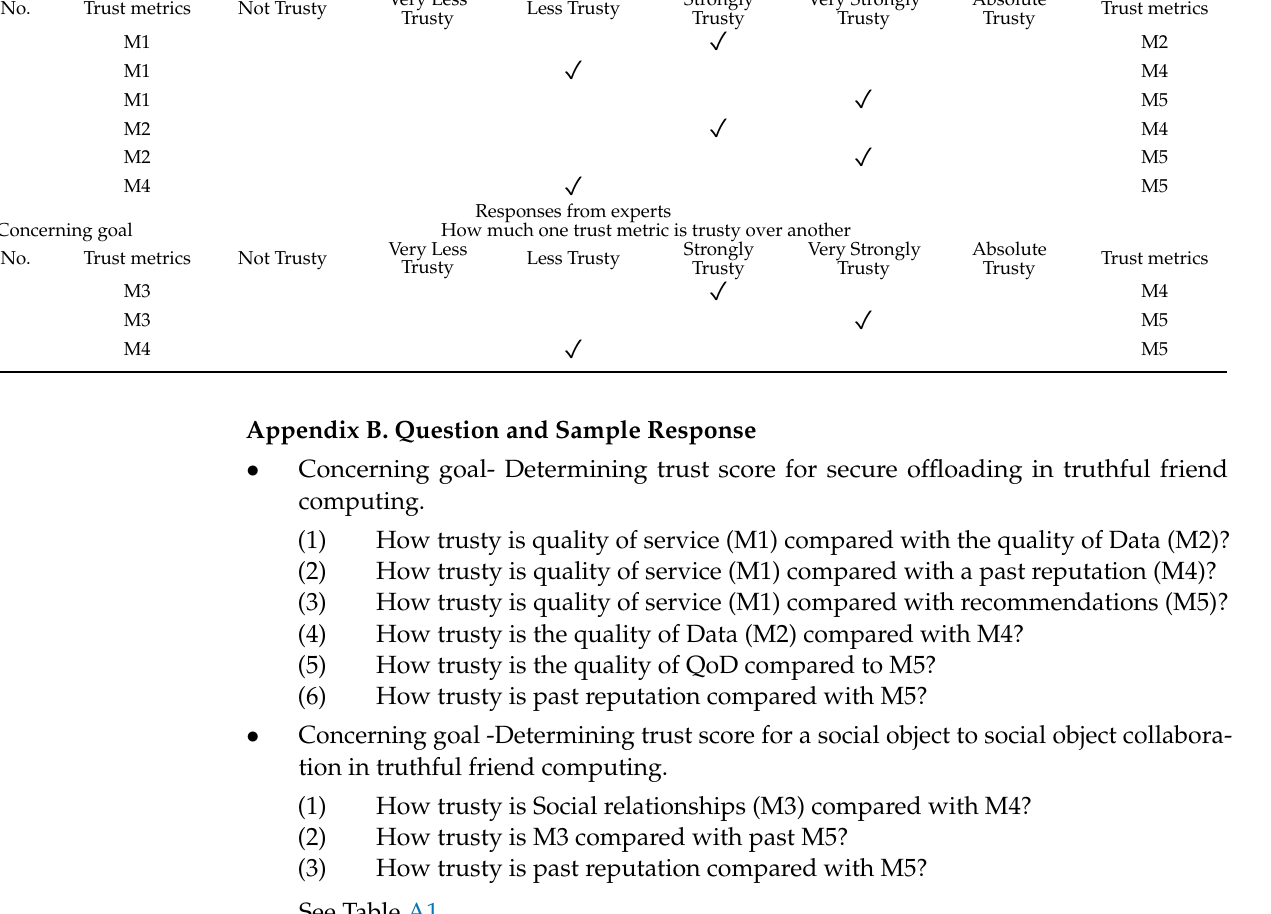
Table A1. Sample responses.